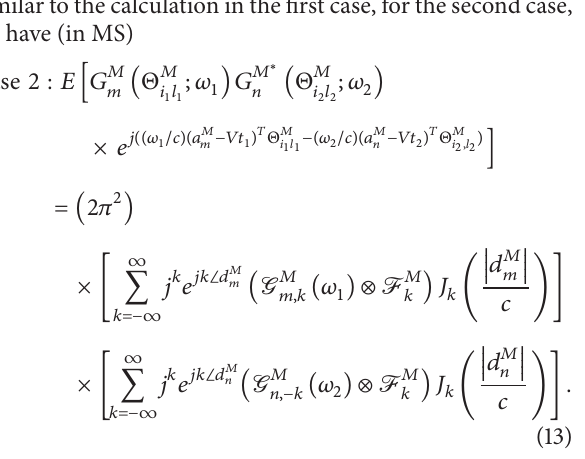
Figure 1: Fourier series coefficients for two AAS PDFs, to approx- imate Laplace and von-Mises distributions (with orders of non- isotropy 𝑛 = 3,10 ) determined to correspond to the real PDFs for the nonisotropic propagation